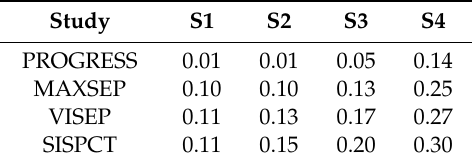
Table 5. 28 d mortality risk in dependence on study and disease state.